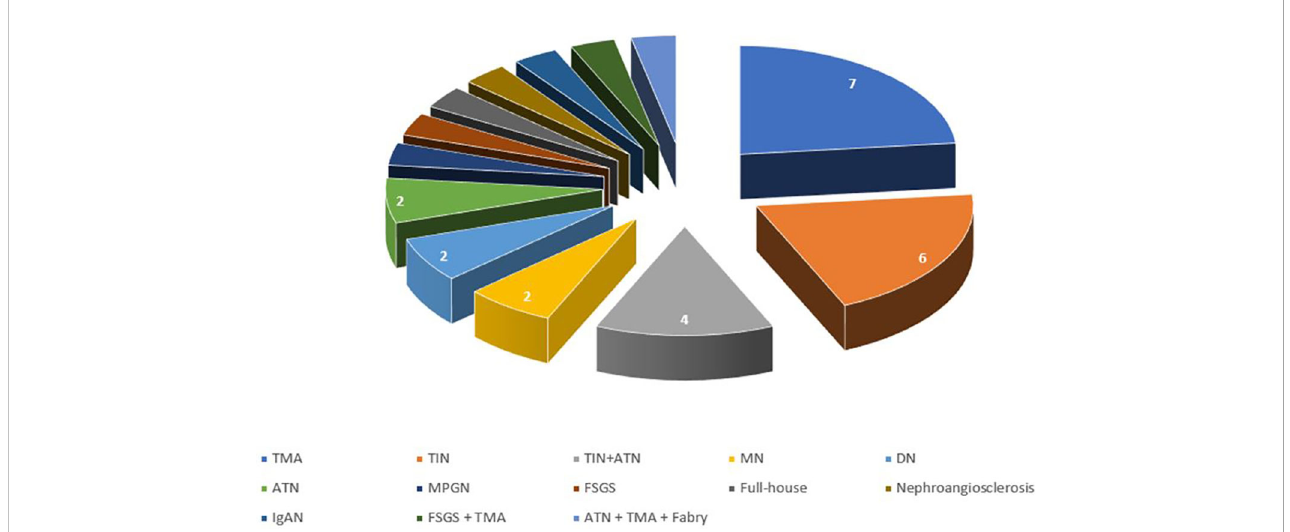
FIGURE 2 Distribution of histological diagnosis. TMA, thrombotic microangiopathy; TIN, tubule-interstitial nephritis; ATN, acute tubular necrosis; MN, membranous nephropathy; DN, diabetic nephropathy; MPGN, membranoproliferative glomerulonephritis; FSGS, focal segmental glomerulosclerosis; IgAN, IgA